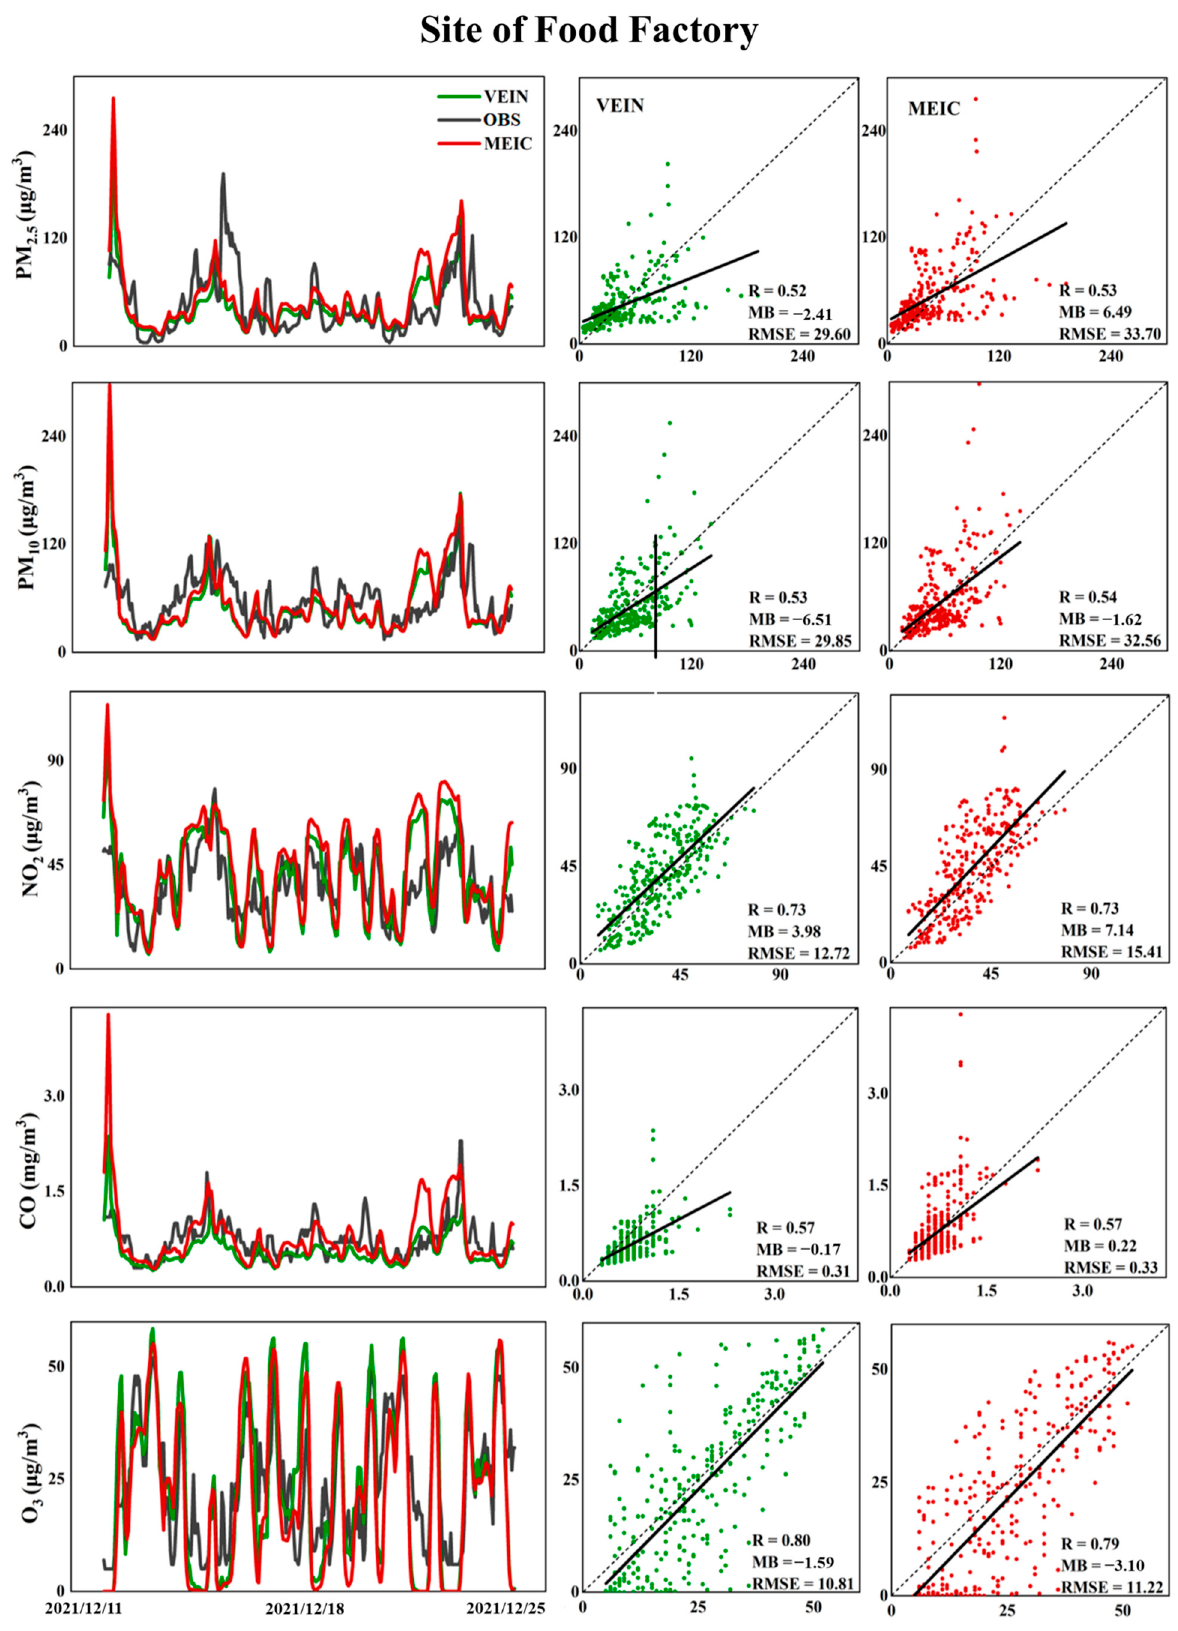
Figure 5. Comparisons between simulations with/without updated traffic emissions and observa- tion of various pollutants with statistical metrics at the site of Food Factory from 11 December to 24 December.